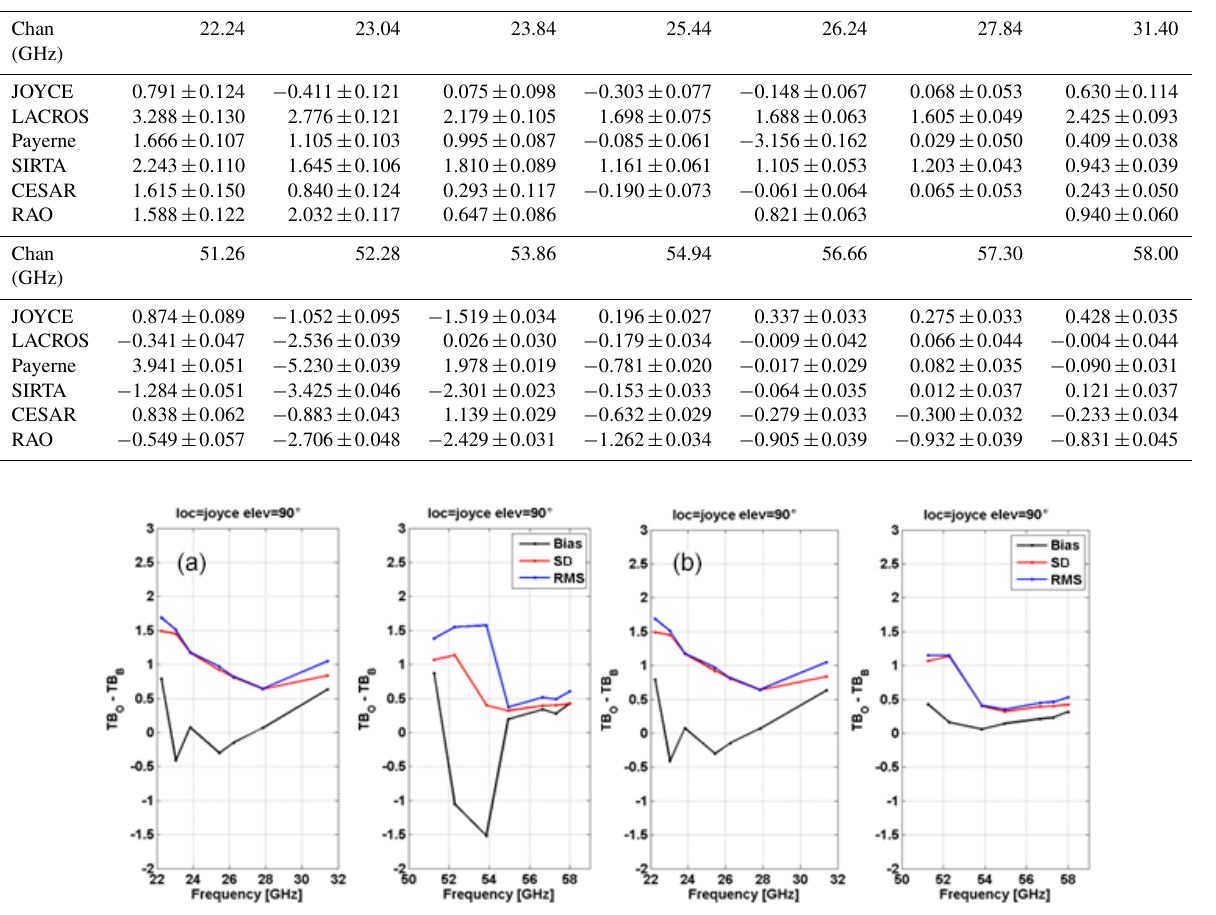
Figure 4. Statistics of the differences between observations and background TB, as in Fig. 3. Here, results from JOYCE at zenith are shown. Panels (a) and (b) refer, respectively, to before and after the bias correction with the COSMO-DE model. Biases are shown with black lines, standard deviations with red lines, and RMS with blue